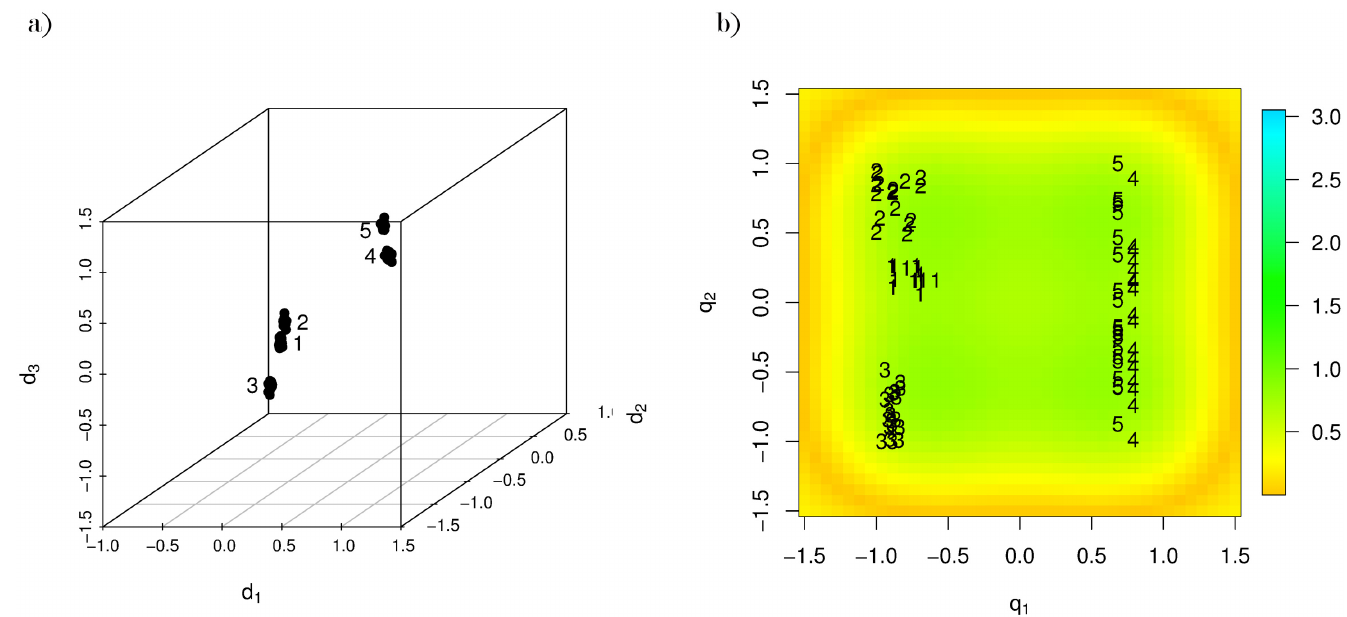
Fig 2. A simulated three-dimensional dataset from five Multivariate Normal distributions and its GTM visualization. Fig a) shows that there are two groups of clusters in three dimensions. The first group includes clusters 1, 2, and 3. The second group includes clusters 4 and 5. Fig b) provides a two- dimensional visualization of the data using